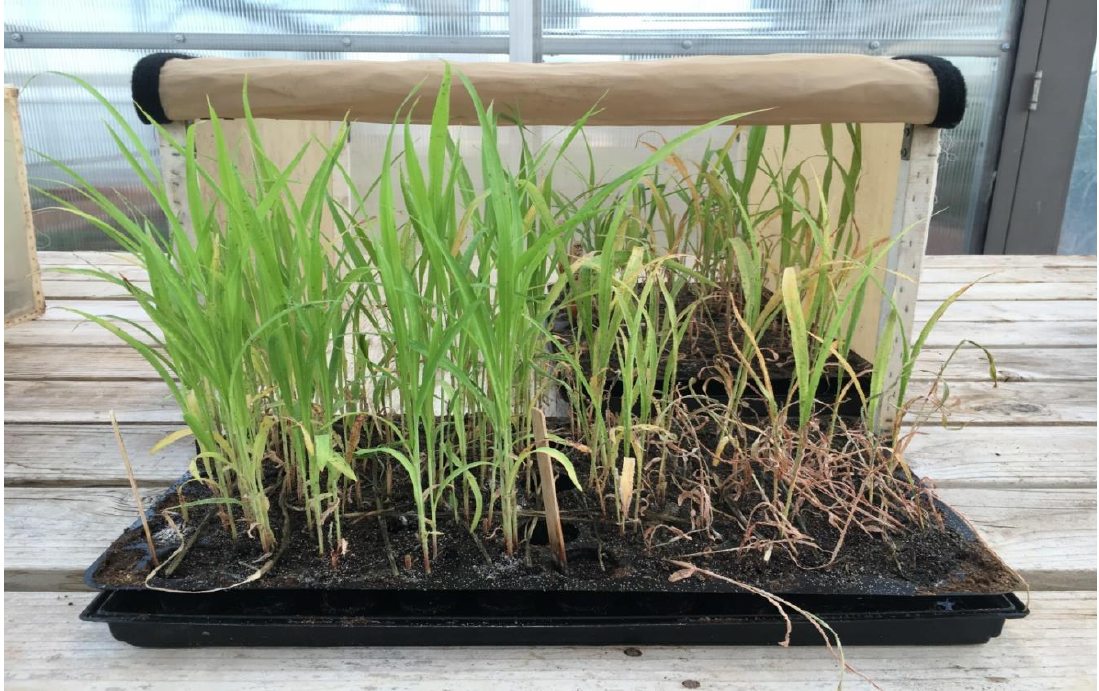
Figure 2. Phenotypes of two sorghum genotypes, Tx2783 (resistant, left ) and BTx623 (susceptible, right ) were photographed after co-cultivation with sugarcane aphids for 12 days.